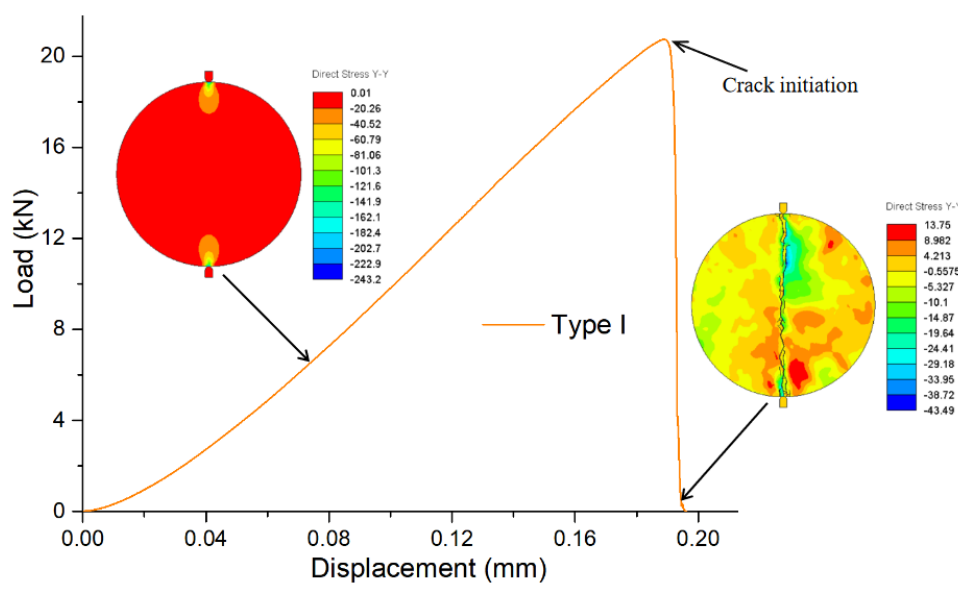
Figure 5. Load − displacement curves for the Type I Brazilian disc testing.